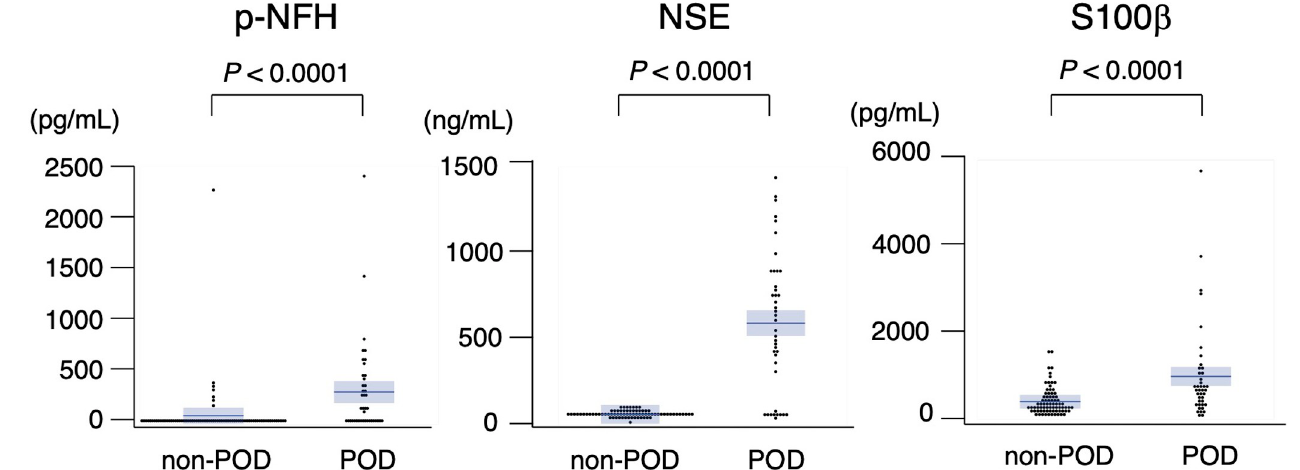
Fig 2. Comparison of serum biomarker levels in patients with and without postoperative delirium.